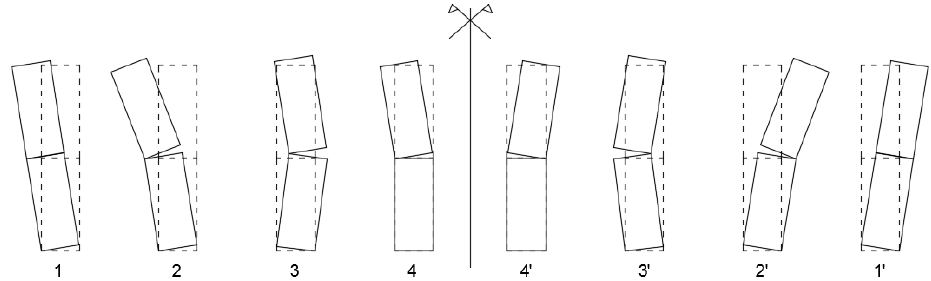
Figure 3. Eight ( N = 8 = 4 + 4) possible configuration patterns of a two-rigid block ( n = 2) system (adapted from [39]).